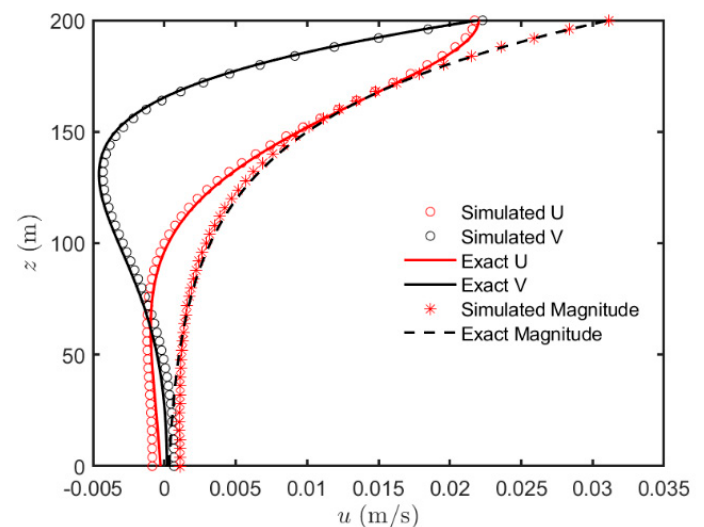
Figure 6. Comparison between the numerical results and the analytical solution for individual velocity components and velocity magnitude for the Ekman profile.